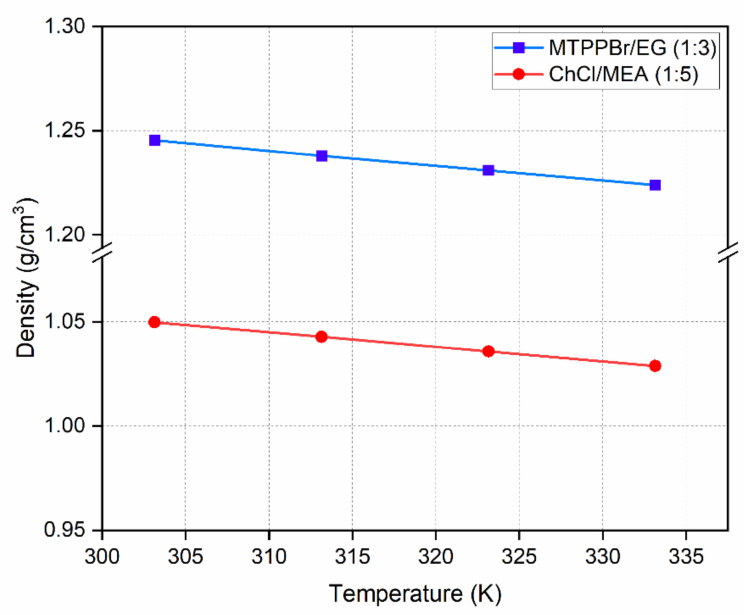
Figure 7. Density of DESs as a function of